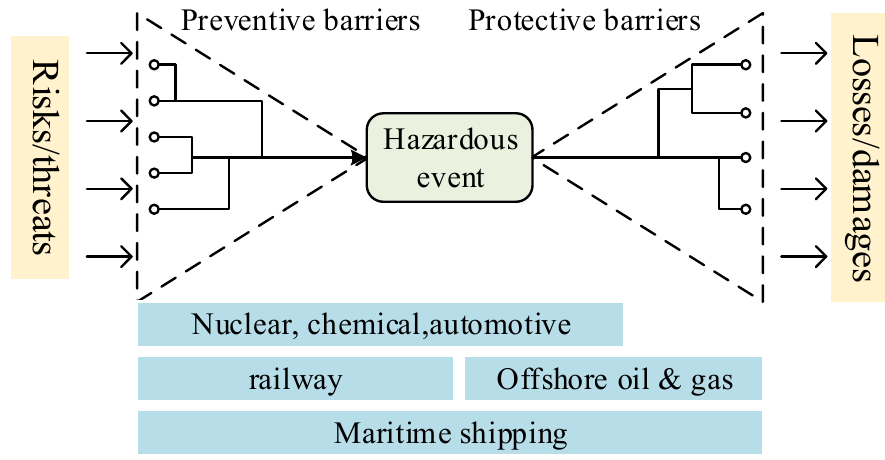
Figure 2. Emphasis of risk control for different industries [8].